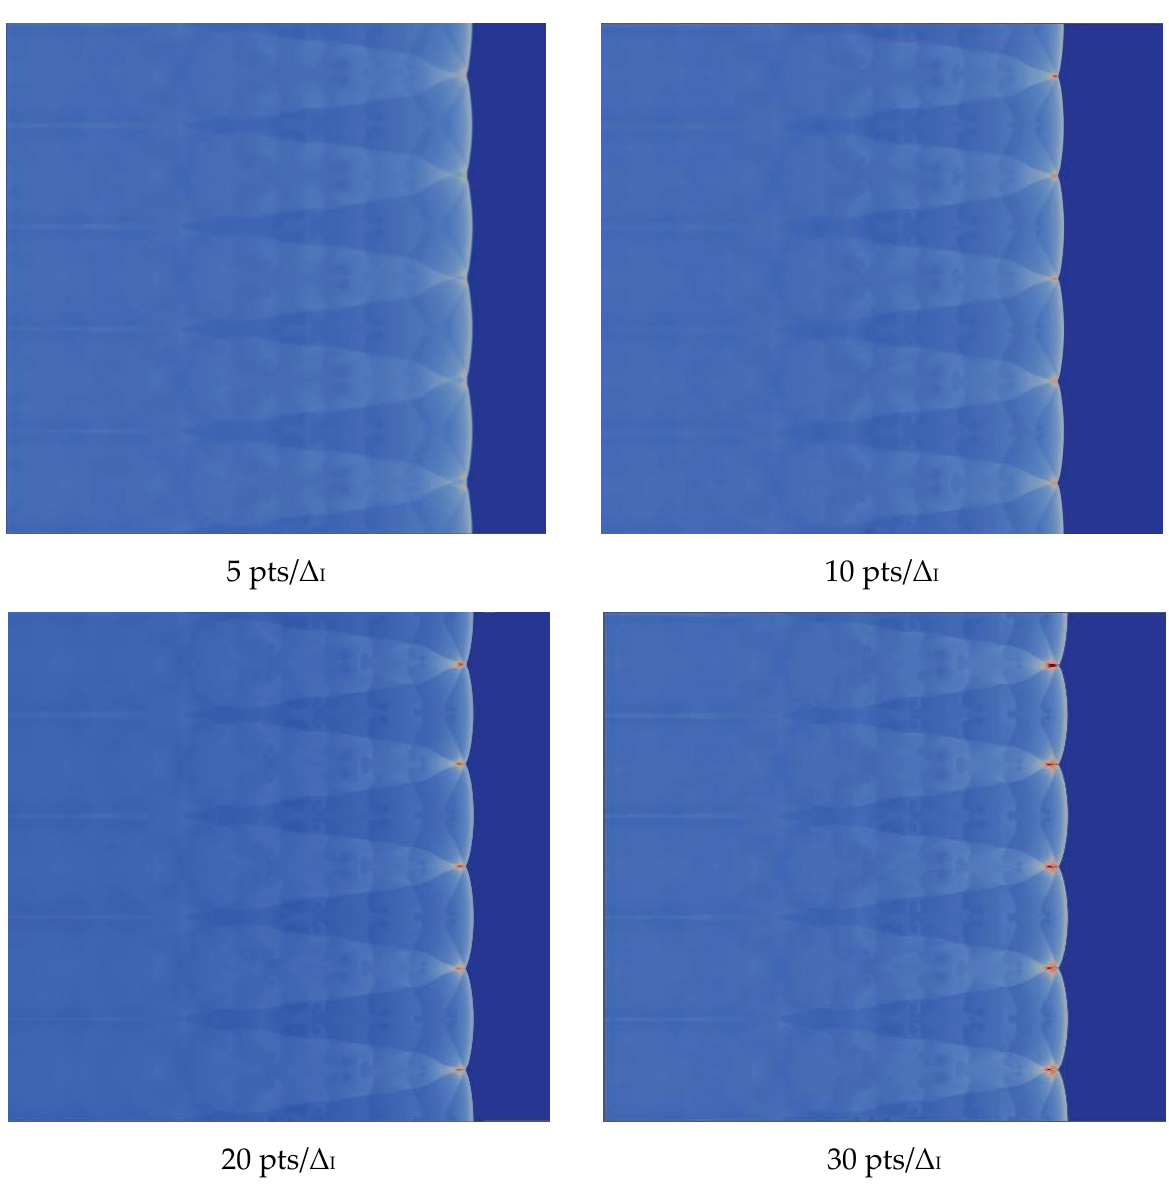
Figure 5. Triple structure comparison results.